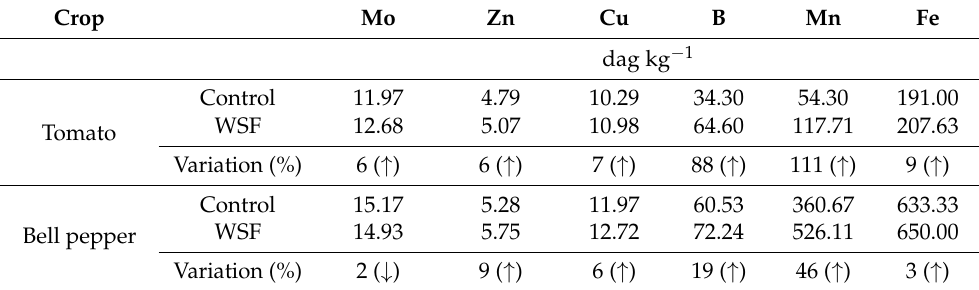
Table 3. Content of micronutrients in infested-RKN tomato and bell pepper tissues treated with different water-soluble fractions (WSF) extracted from vermicomposts. Upwards pointing arrows indicate an increase and downwards pointing arrows indicate a